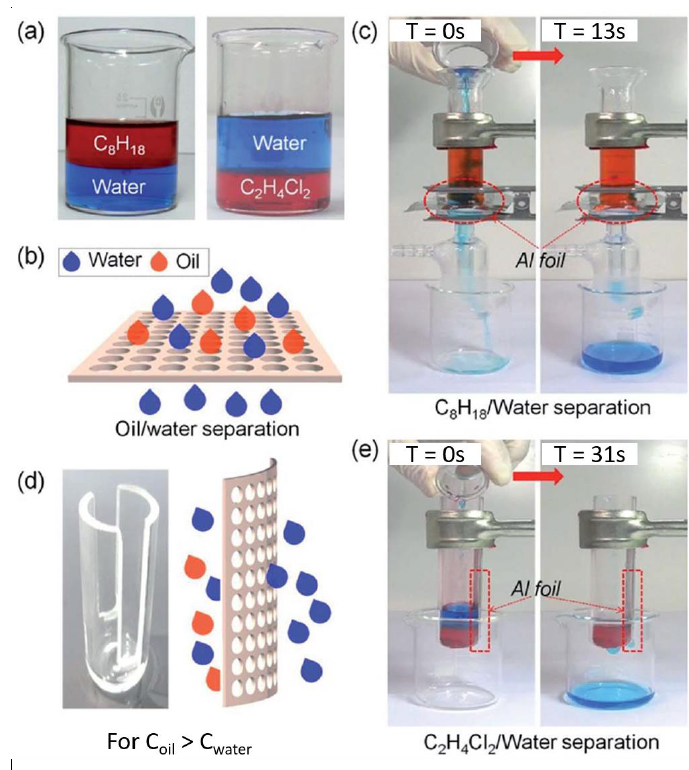
Figure 12. ( a ) Oil–water mixture of heavy and light oil. ( b ) Schematic of the light oil–water separation process; ( c ) oil–water separation was completed within 13 s in the case of the octane light oil. ( d ) Tube with side opening and schematic of the heavy oil–water separation process; ( e ) the heavy oil–water separation process was completed within 31 s [70]. Reproduced with permission from [70] Royal Society of Chemistry